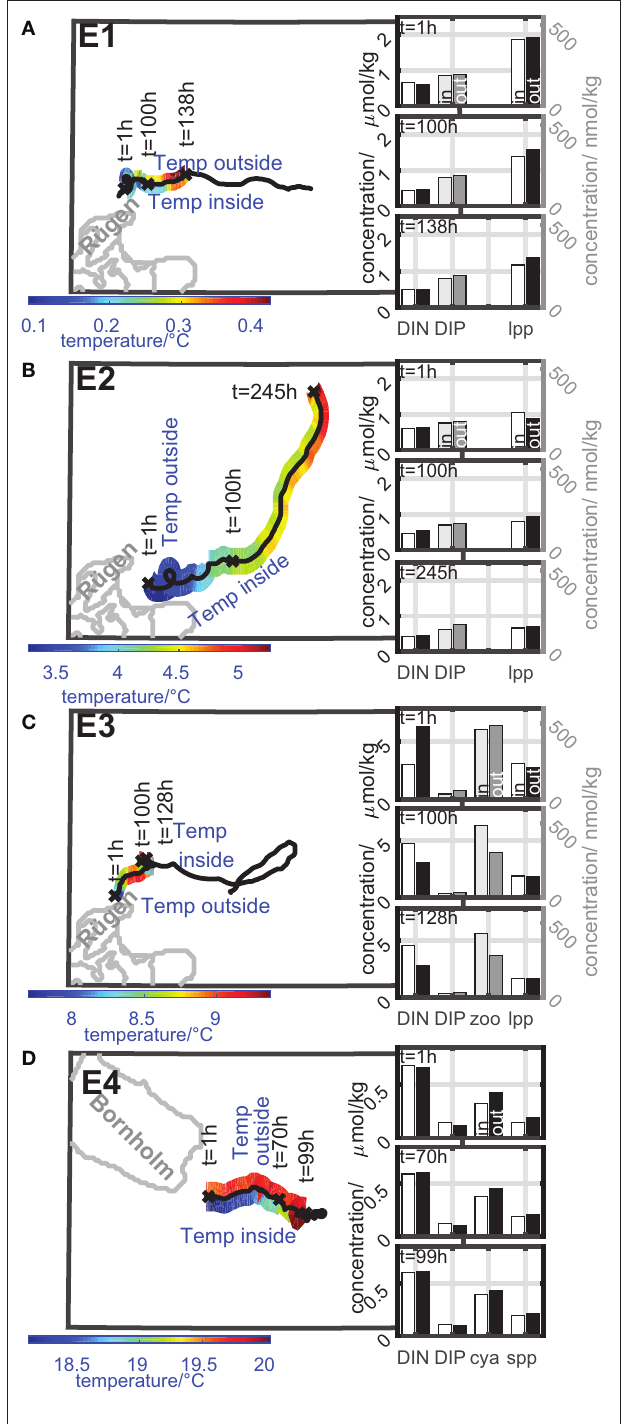
FIGURE 6 | Color-coded dynamics of the temperature inside and outside the eddy along the eddy track during its coherence time of eddies with transporter properties ( (A) E1, (B) E2, (C) E3, and (D) E4). Insert bar plots: concentration of nutrients and selected plankton groups inside and outside the eddy at selected timesteps of the concentration time series. Left concentration axis: black and white bars; right concentration axis: gray scaled bars. Dynamics inside the eddy: white and light gray bars; dynamics outside the eddy: black and dark gray bars. Further details see